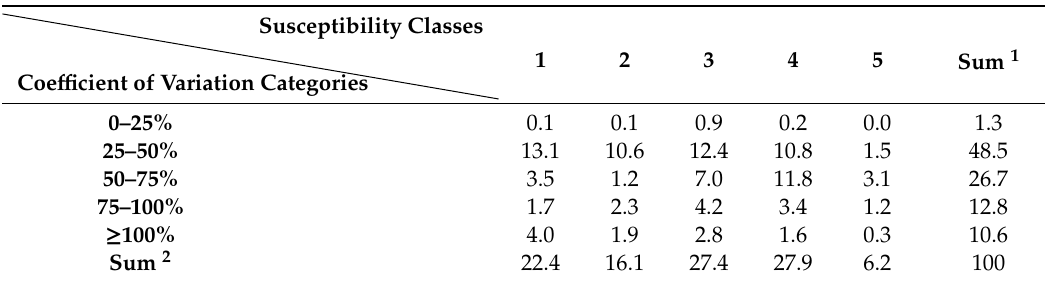
Table 1. Percentages of area covered by each susceptibility class and each category of coe ffi cient of variation within the study area.